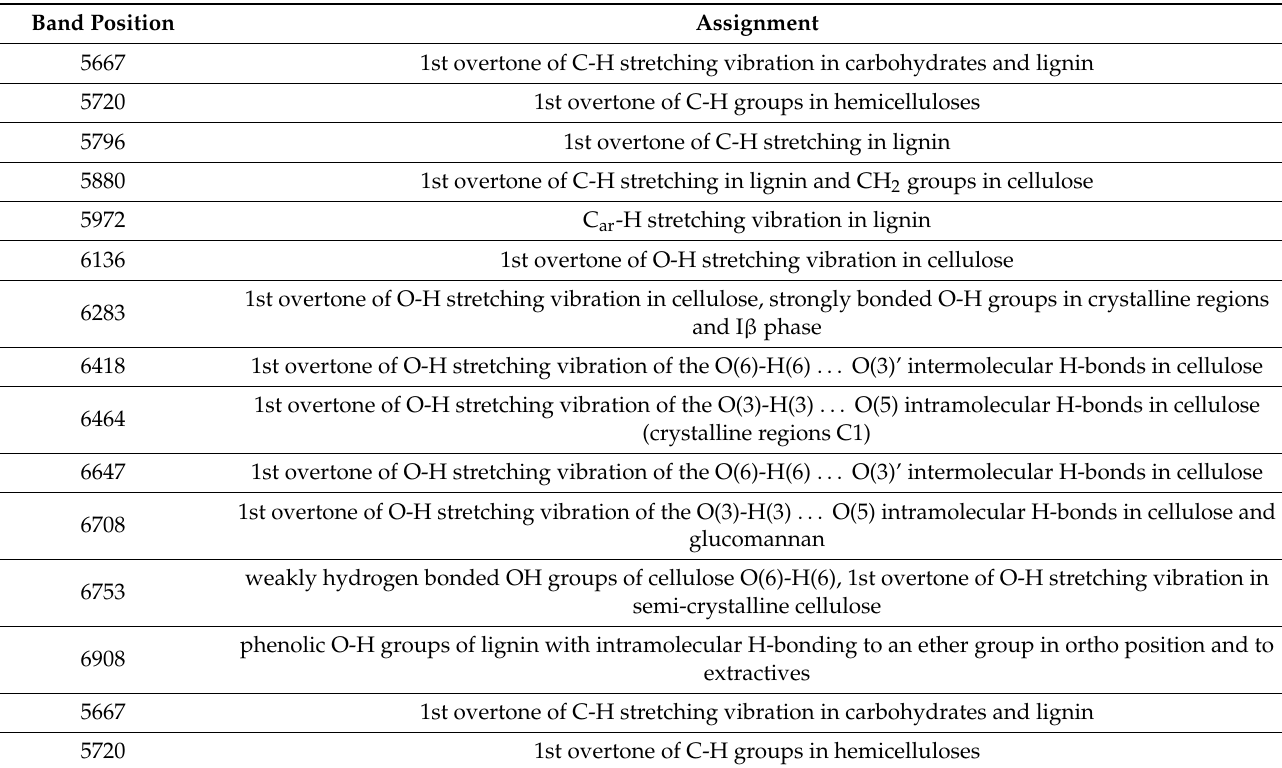
Table 2. Band position and their assignment in the 5600–6950 cm − 1 region [7,23,37–39]. Band Position